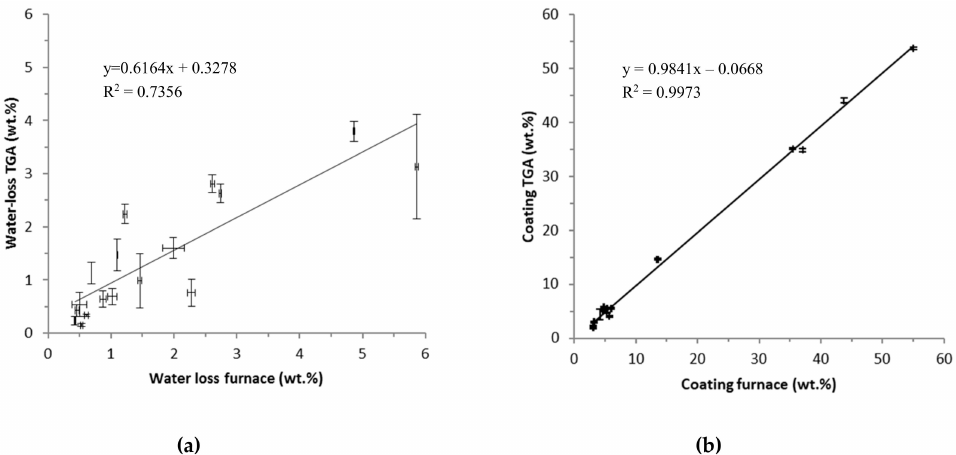
Figure 2. Water loss ( a ) and potential organic coating on MNM ( b ) estimated by TGA versus the furnace method. The error bars represent the standard error of mean, but are not visible for amount of